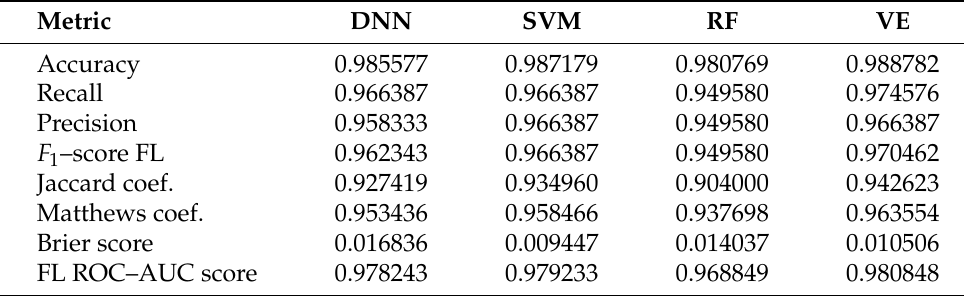
Table 2. Classification metrics of different classifiers measured on a test